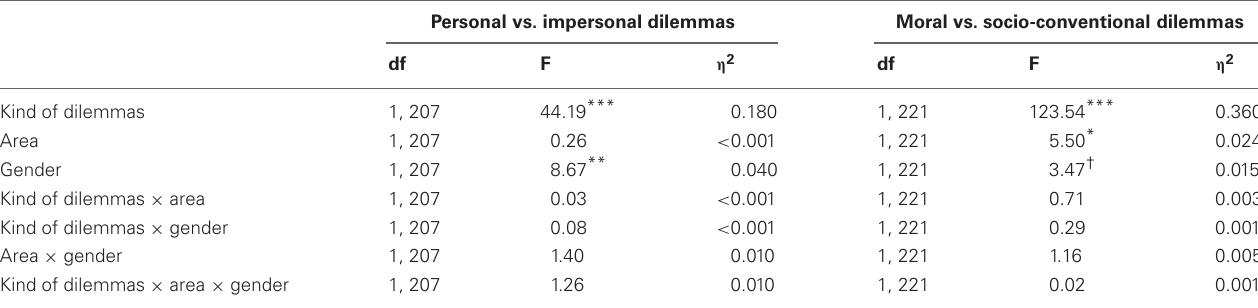
Table 3 | Summary of ANOVA for personal vs. impersonal and moral vs. socio-conventional dilemmas, including area as fixed factor.